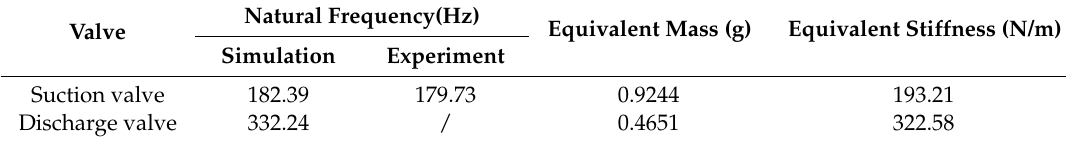
Table 1. Stiffness, natural frequency and equivalent mass of the